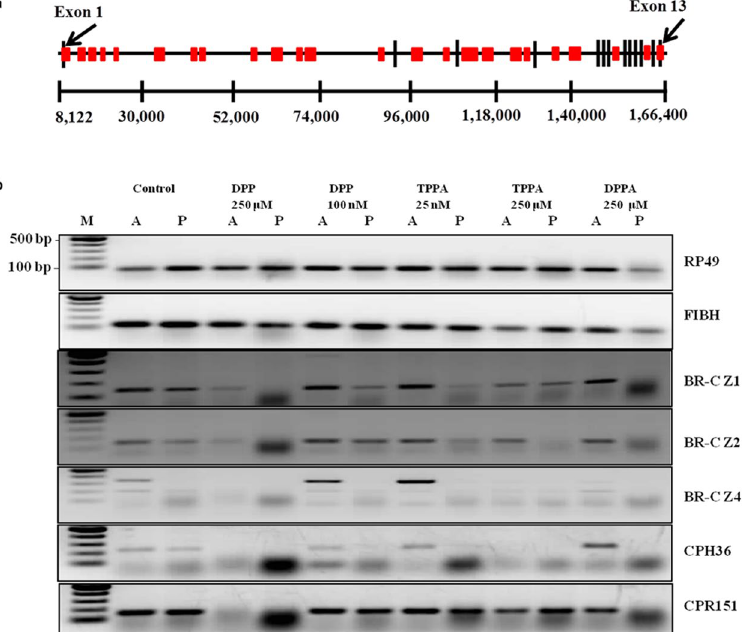
Figure 4. TTAGG enriched BR-C gene and its transcription along with other TTAGG genes. ( a ) A schematic representation of BR-C gene. The exons and introns are indicated. The red boxes indicate 5 ′ -TTAGG-3 ′ repeats. Lines connect the actual order of the exons. TTAGG repeats are not to scale. ( b ) RT-PCR data for expression of RP49, FIBH, broad-complex isoforms (BR-C Z1, BR-C Z2, BR-C Z4) and putative cuticle protein genes (CPH36 and CPR151). ‘A’ and ‘P’ denote anterior and posterior silk